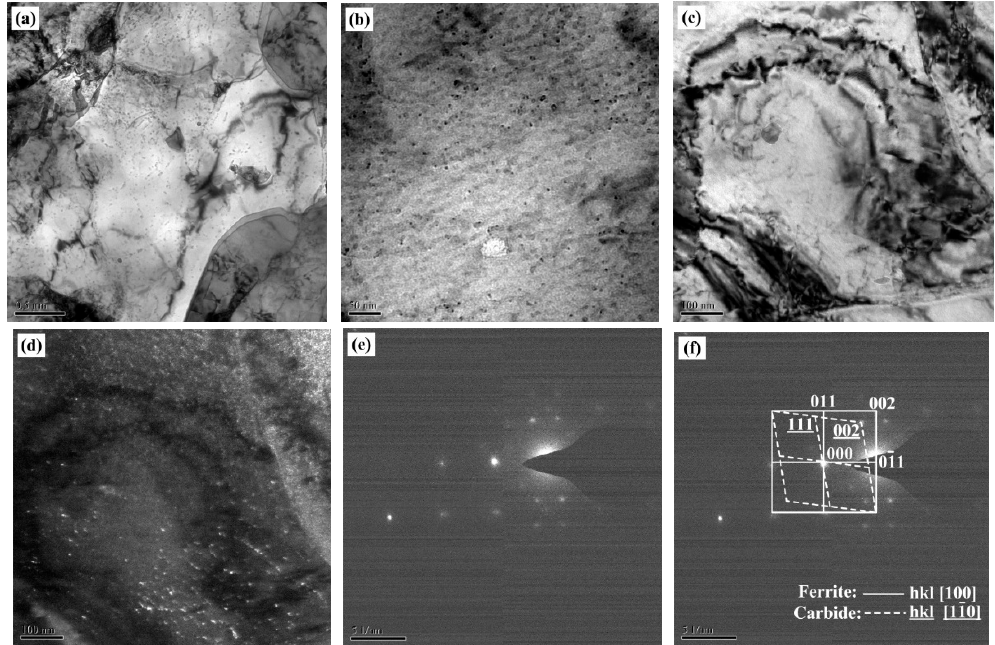
Figure 6. Precipitation observation of 25.4 mm X70 pipeline strip: ( a – c ) morphology of precipitates, ( d ) dark field image of precipitates, ( e , f ) crystallographic orientation between matrix and precipitates.